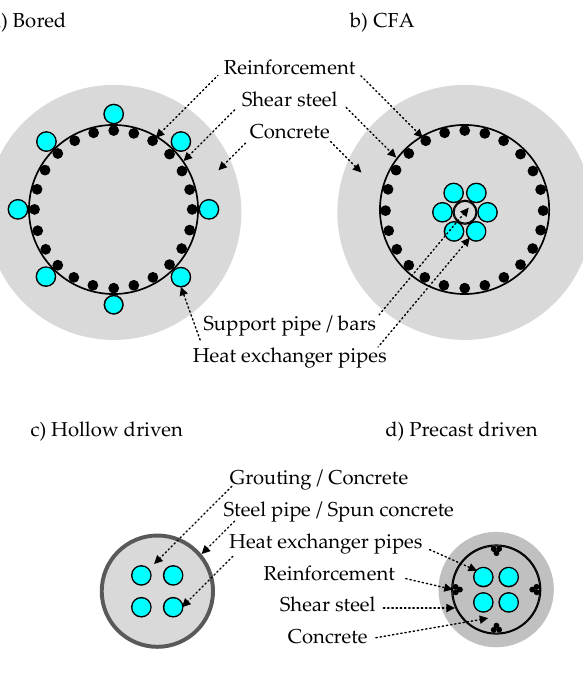
Figure 1. Common types of energy piles.